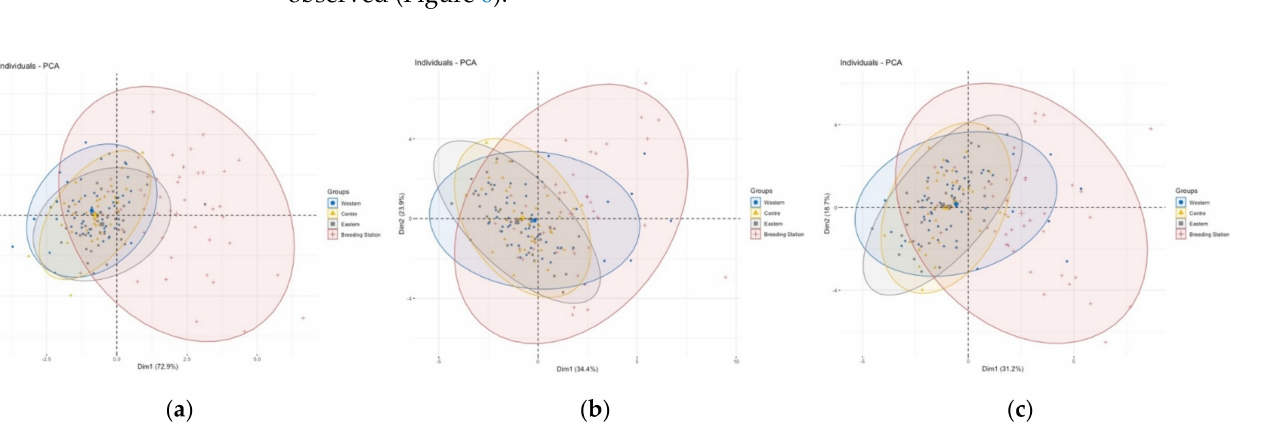
Figure 6. PCA of the bills from the locations of Chukar Partridges. The colours represent localities, blue: western, yellow: centre, grey: eastern, red: breeding station. ( a ) Morphometric ( M ; size), ( b ) geometric morphometric ( GM ; shape), and ( c ) M + GM